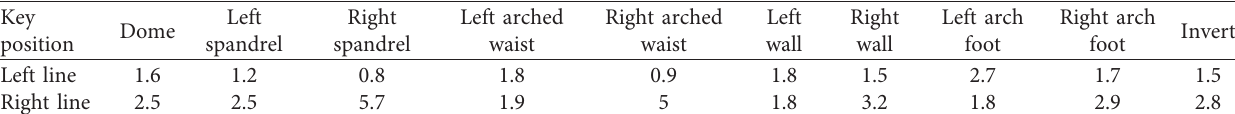
Table 13: Safety factors of lining